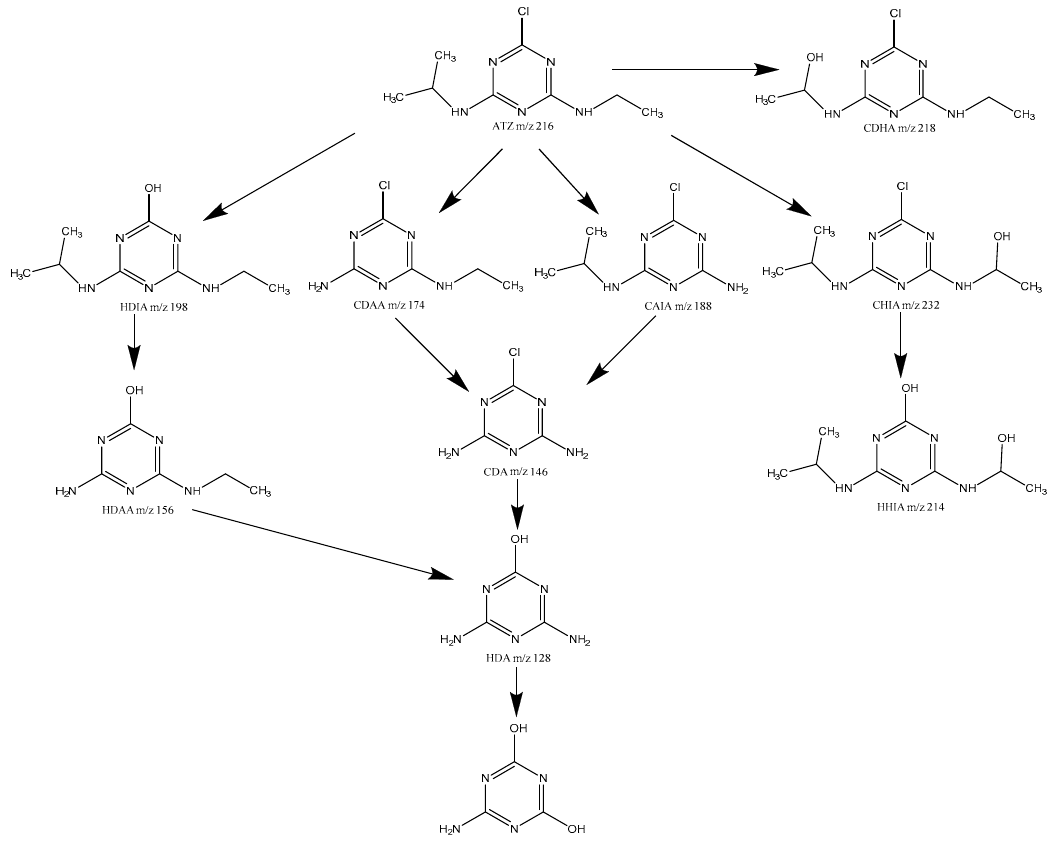
Figure 9. The possible degradation pathway of ATZ.